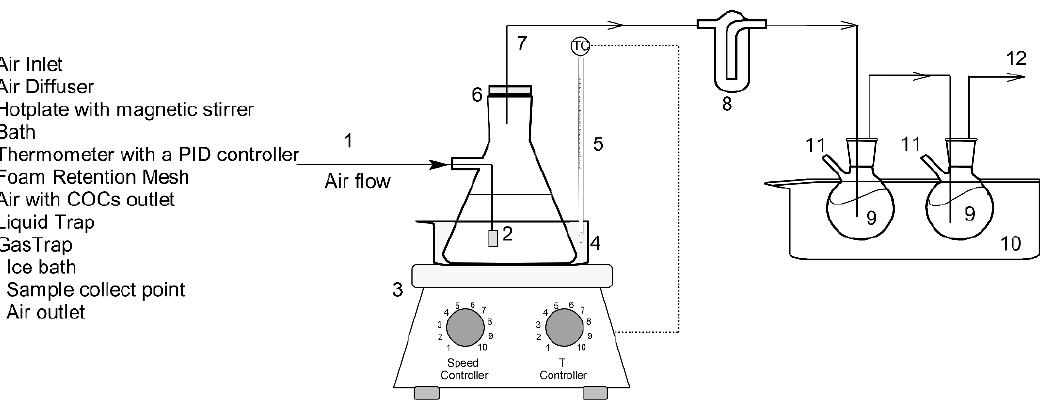
Figure 1. Scheme of the installation used for volatilization tests.